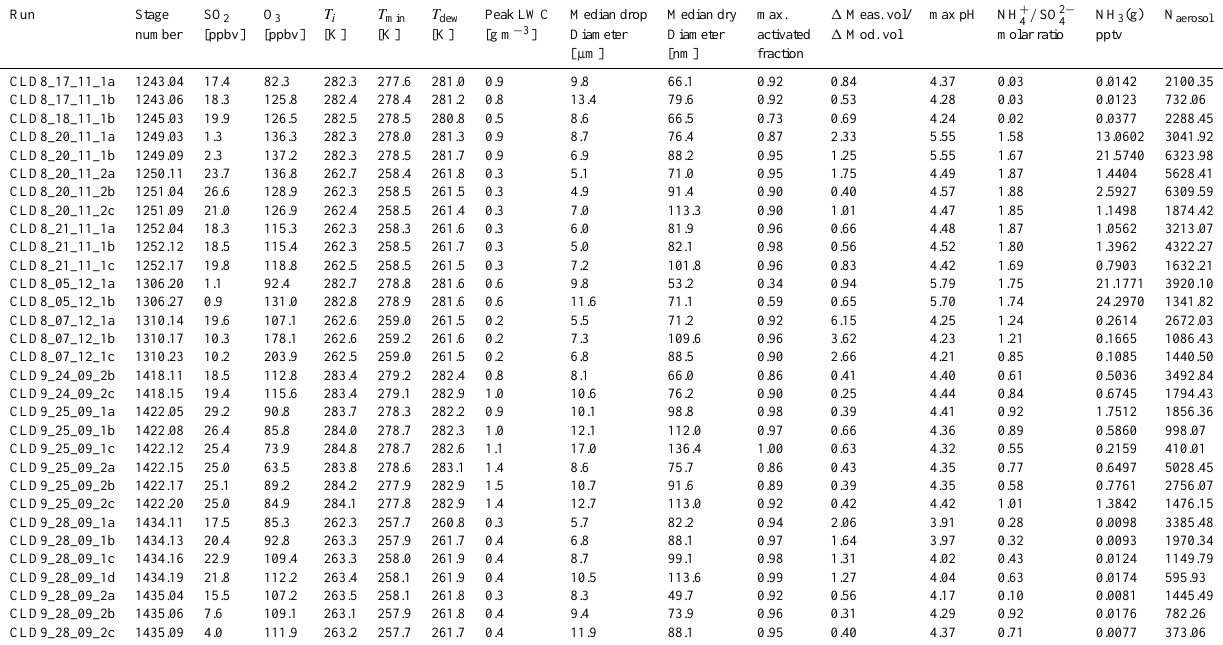
/ SO 2 − molar ratio is calculated 4 4